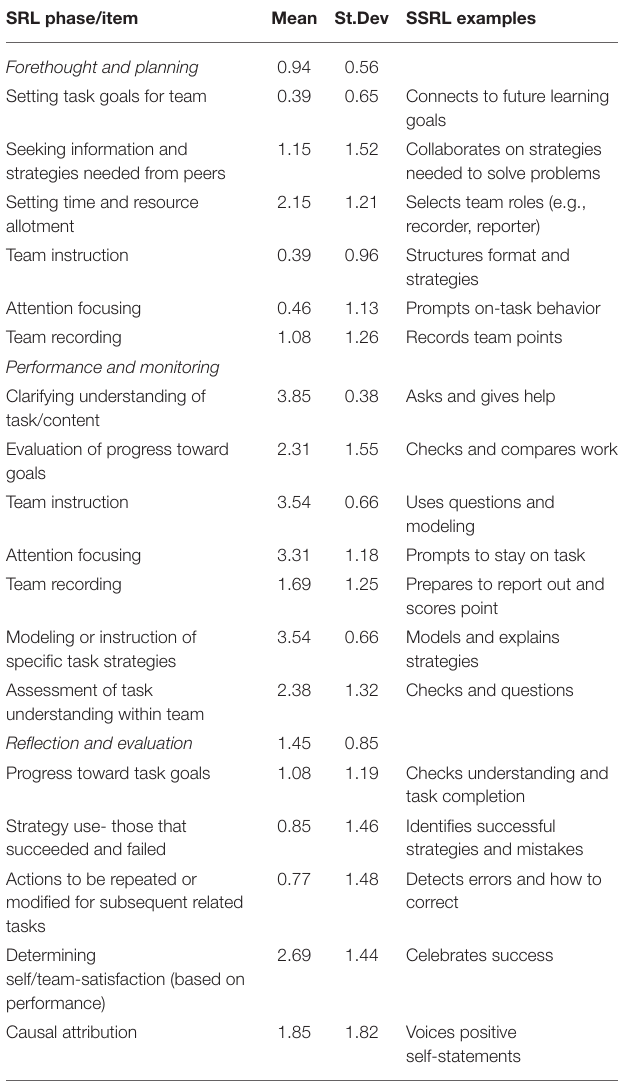
TABLE 2 | Student observation scores and example